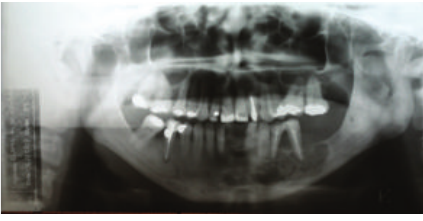
Figure 2: X-ray showing the lesion limits.